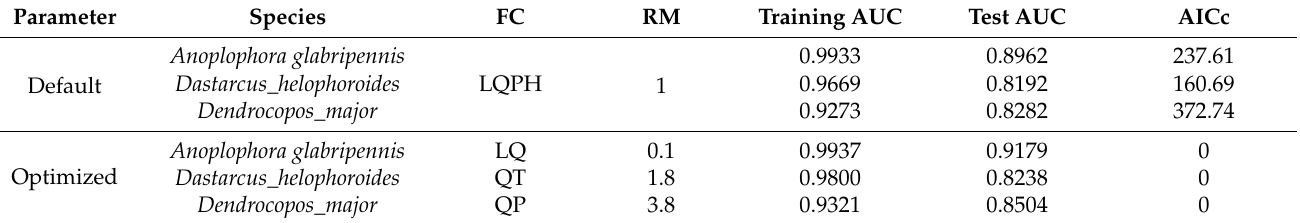
Table 2. Akaike information criterion calculated in the Kuenm evaluation to select the best model